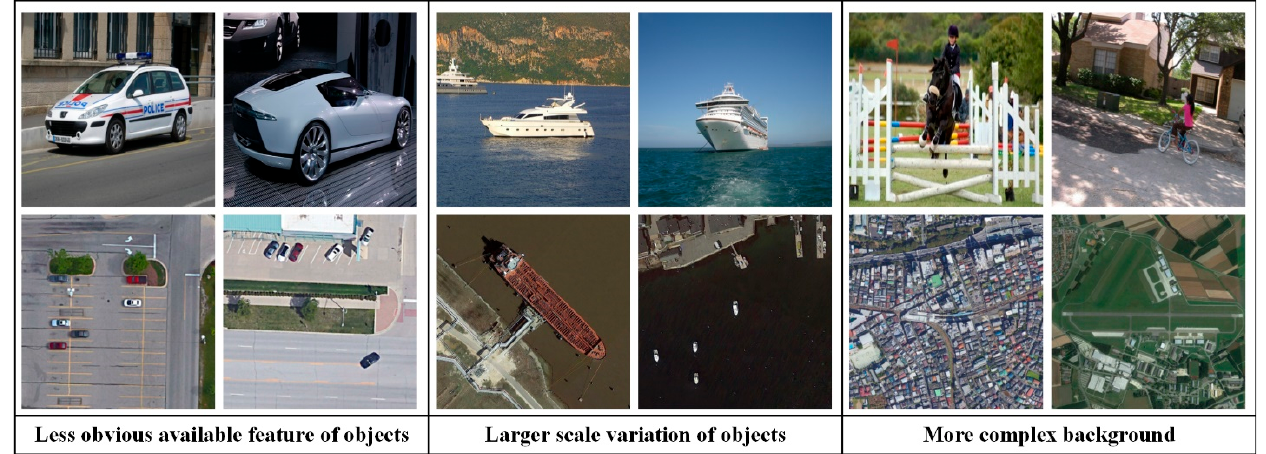
Figure 1. Three main differences between RSIs and NSIs. The first and second lines show instances from NSIs and RSIs, respectively.